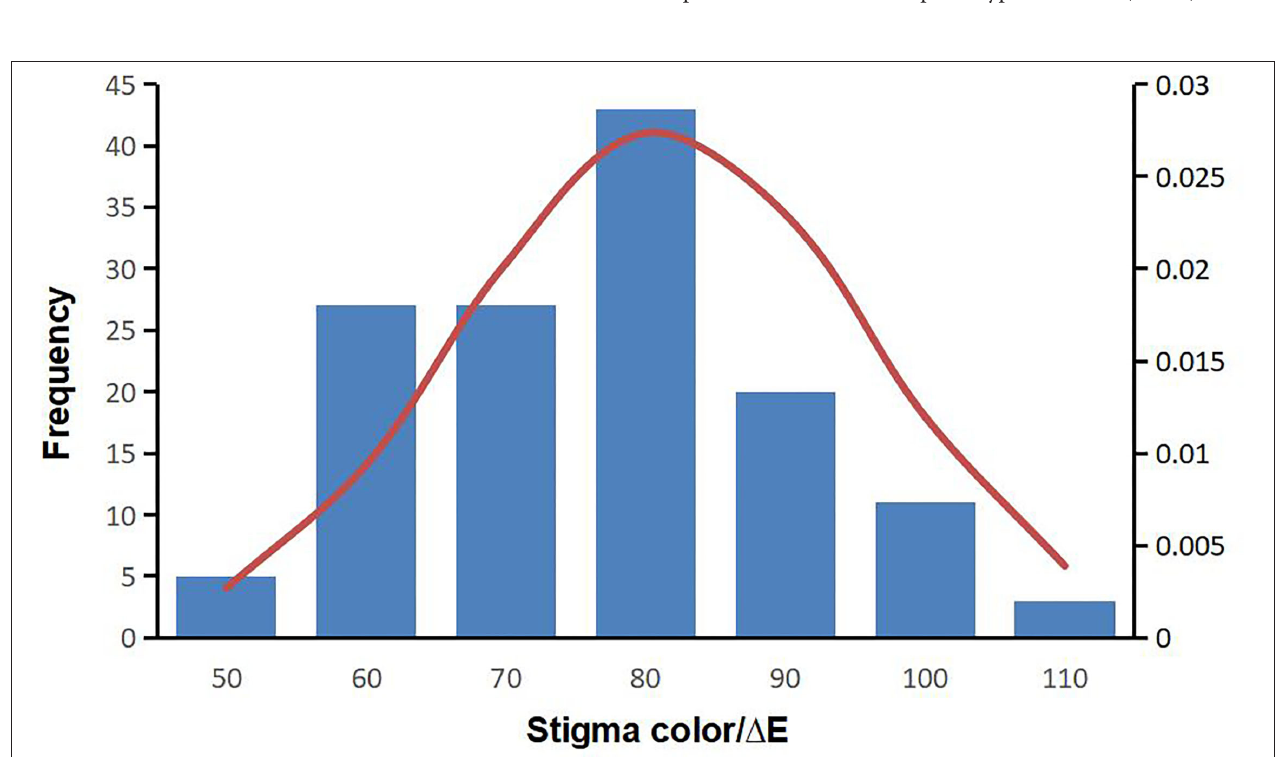
FIGURE 2 | Frequency histogram of stigma E value of the F 2 population in 2019.